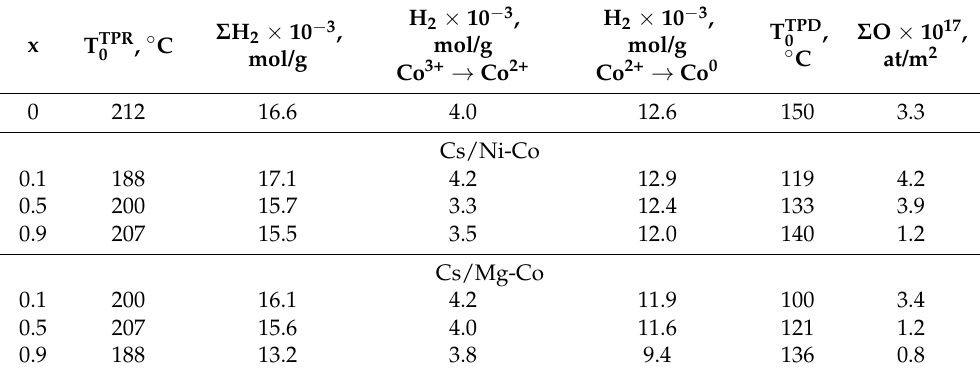
Table 2. H 2 -TPR temperatures of the initial reduction and H 2 consumption. The amount of desorbed oxygen by O 2 -TPD and the initial desorption